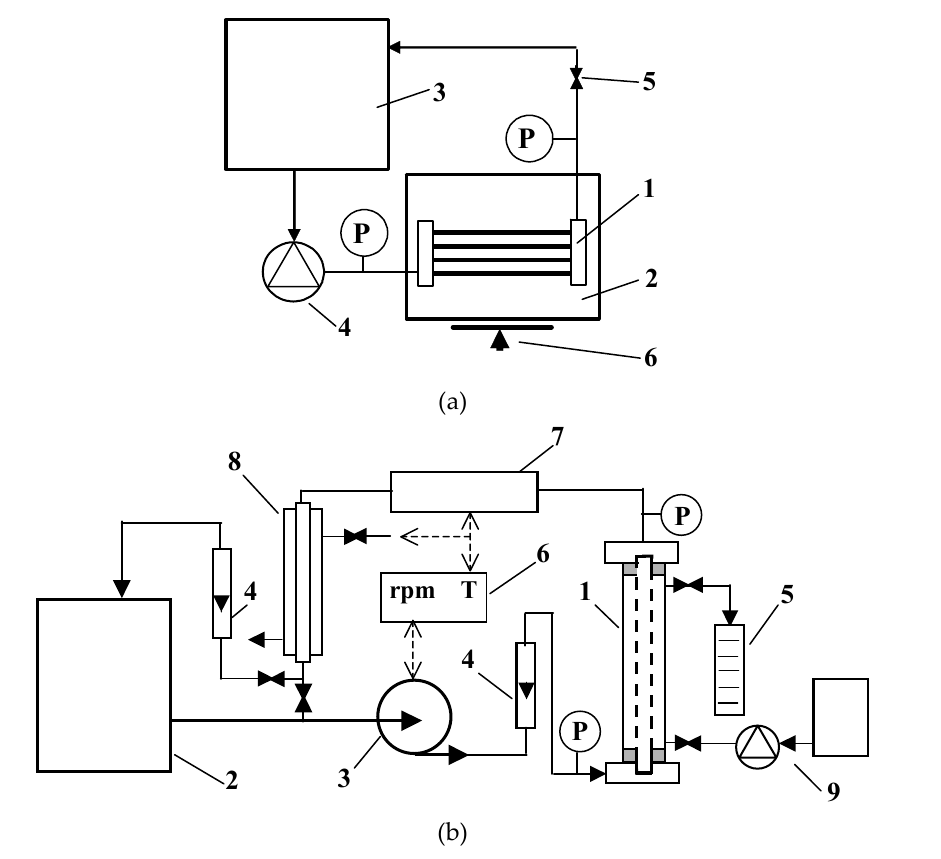
Figure 1. Experimental installations: ( a ) Laboratory trial: 1—polypropylene (PP) module, 2—per-